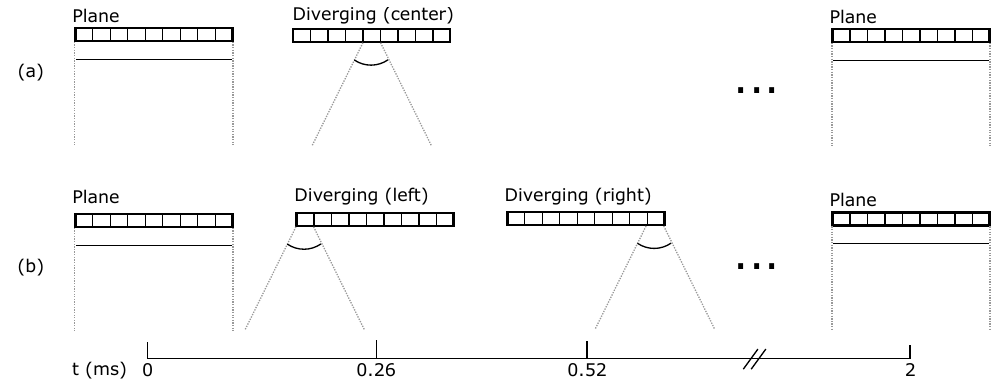
Figure 2. Sample pulse sequences for correlation-based swept synthetic aperture imaging using a 500 Hz frame rate and 260 µ s between pulses to allow propagation and data acquisition. The ellipses represent a gap between transmissions. ( a ) Alternating plane and diverging waves with plane waves to provide highly correlated data and diverging waves to provide a wide acceptance angle for coherent combination. ( b ) Diverging waves transmitted from each edge instead of the center to maximize the effective transmit aperture